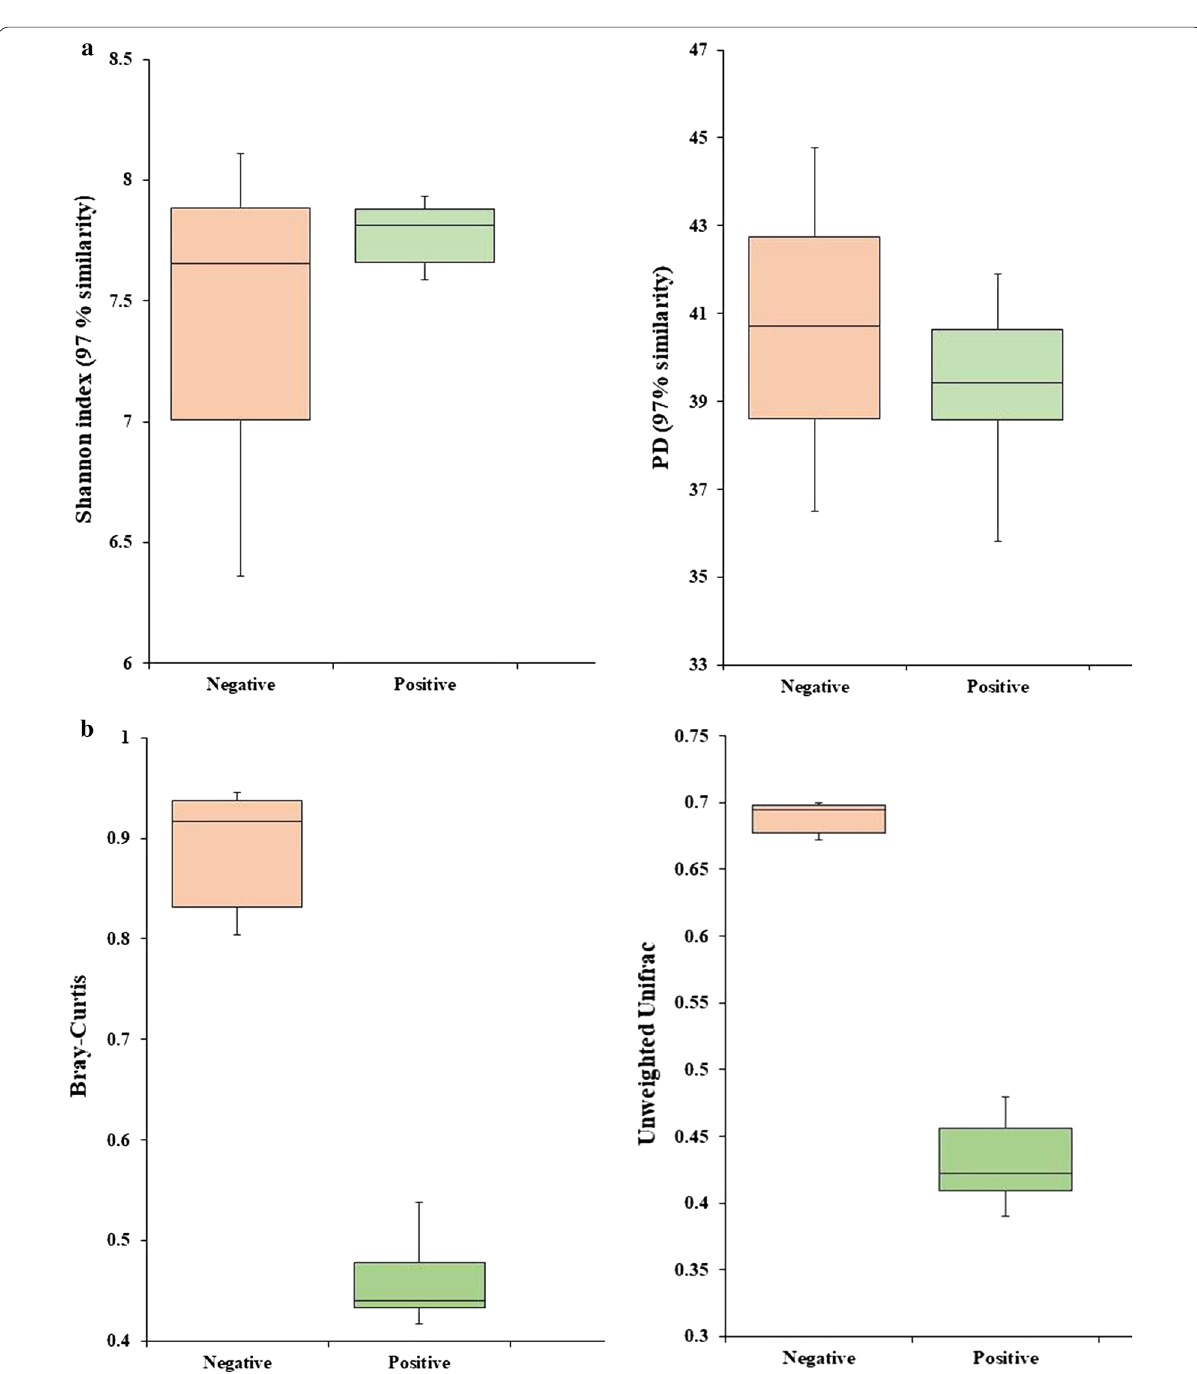
Fig. 1 The comparison of alpha- and beta-diversity between negative and positive soils. a Alpha-diversity (Shannon index and Faith’s Phylogenetic Diversity) and b beta-diversity (Bray–Curtis and unweighted Unifrac distance